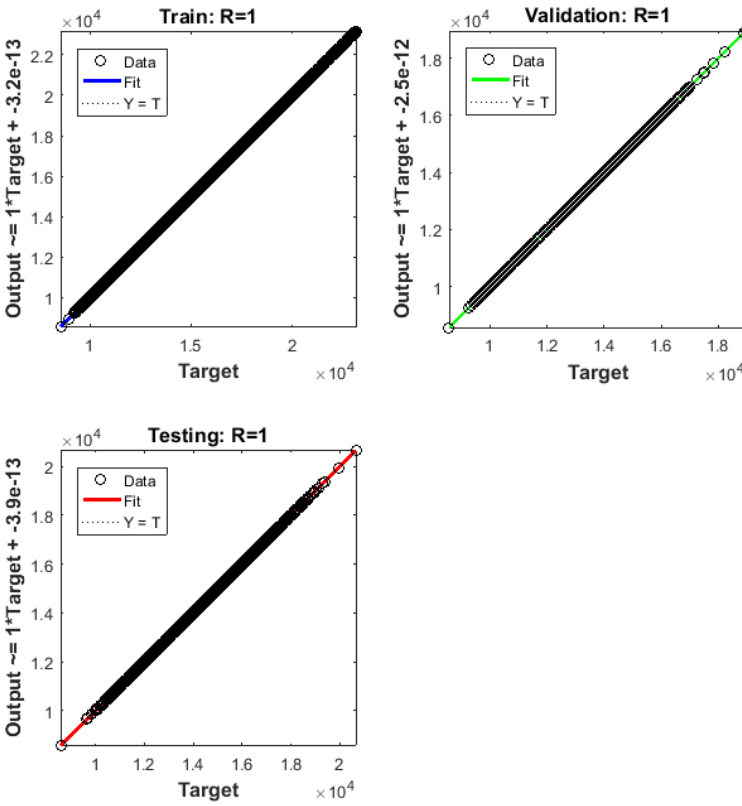
Figure 10. Error regression on forecast vs.